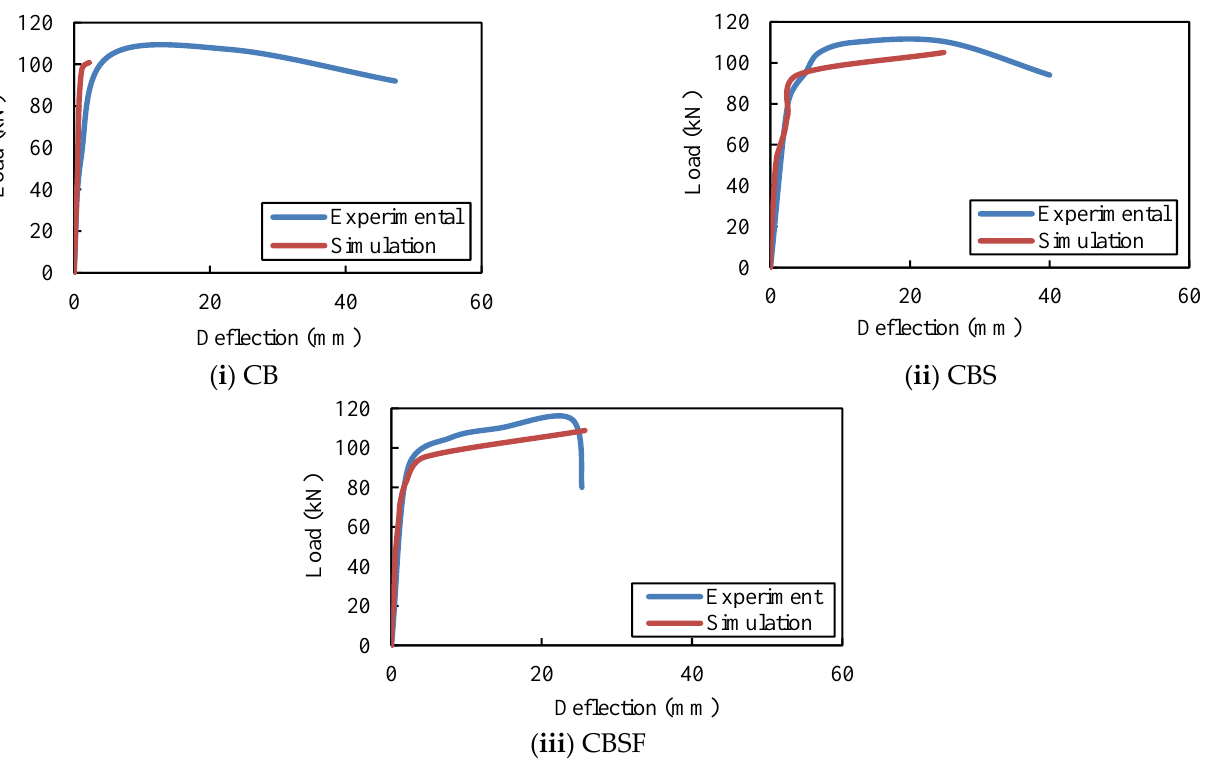
Figure 23. ANSYS and experimental deflections of the composite CFS beams.